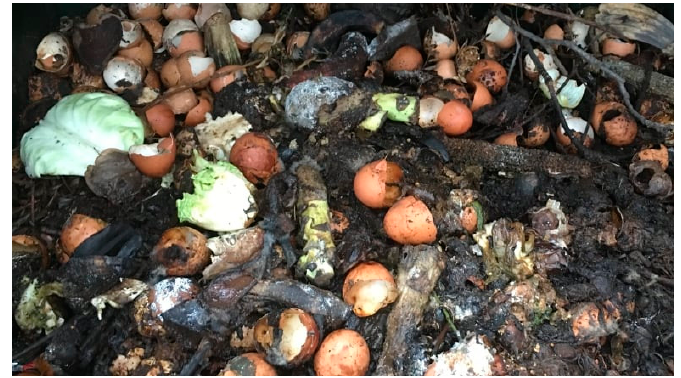
Figure 1. Waste eggshell landfill.